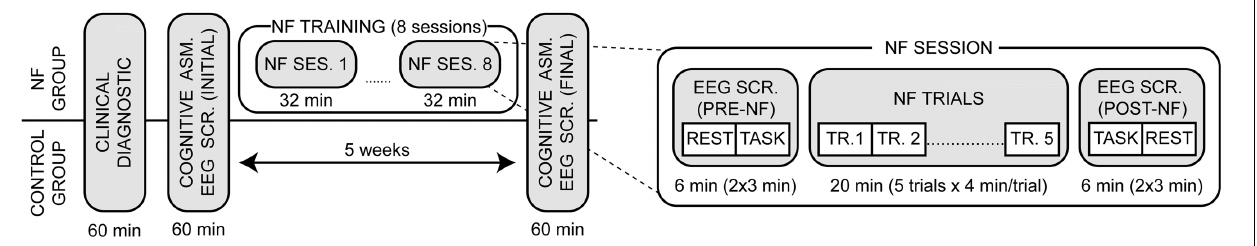
sessions(twosessionsperweek),whichwerecomposedofapre-andpost-EEG screening (6min each) and five training trials (4min each). The EEG screenings included eyes closed resting state and eyes open task-related